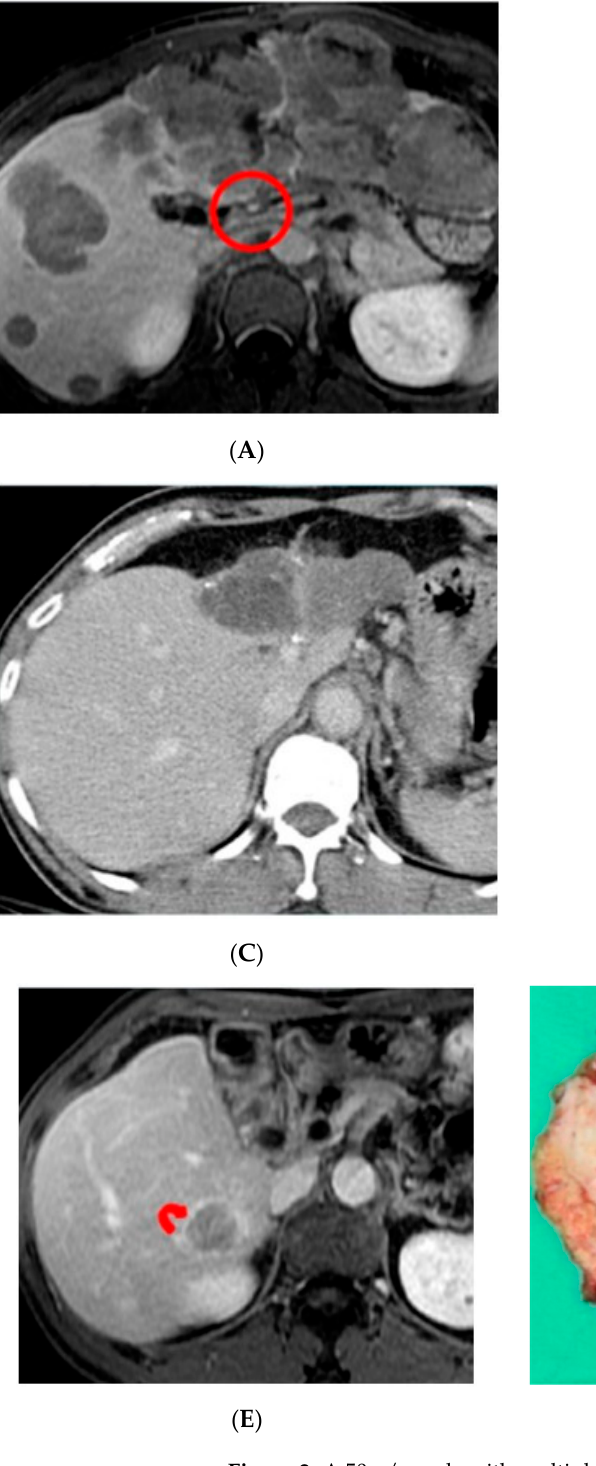
Figure 2. A 50 y/o male with multiple HCC in the bilateral lobe of liver. The largest tumor was 14 cm in the left lobe liver. ( A ). Liver MRI showing tumor invasion into the MPV (circle). ( B ). Chest CT also showing metastatic nodules in the right lung. ( C ). Liver CT showing complete remission after 6 courses of HAIC plus sorafenib therapy. ( D ). Chest CT also demonstrating disappearance of the lung metastatic lesions. ( E ). Liver MRI revealing a new recurrent 3.5 cm HCC (arrow) in the right lobe liver 20 months after the last treatment. ( F ). Surgical specimen showing the recurrent HCC in the right lobe liver and complete necrosis of the atrophic left lobe lesions. At the time of publication, this patient had survived for more than 67